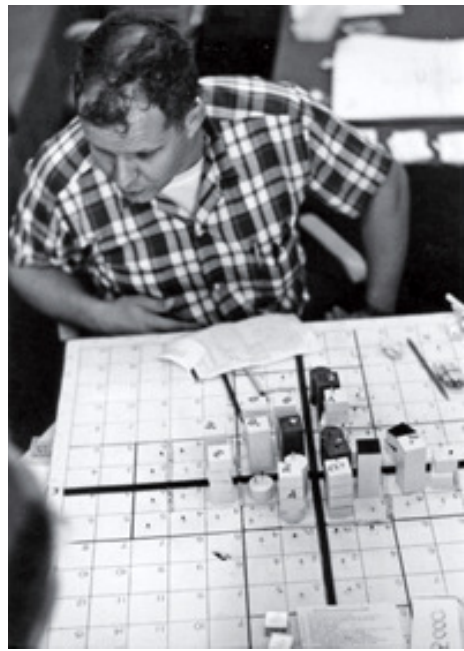
Figure 1. Early version of CLUG, 1966. Source: Feldt (2014, p.